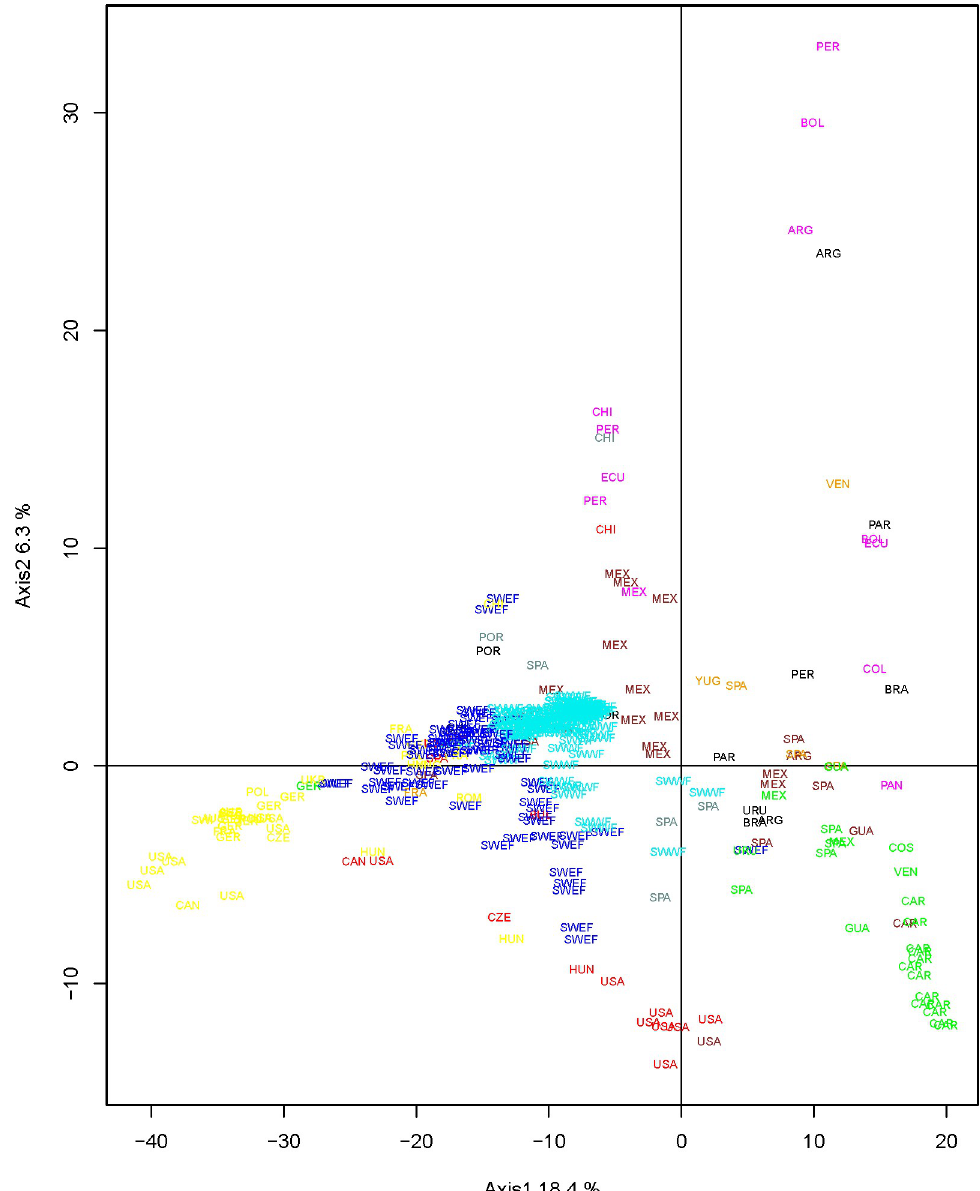
Fig 4. PCA analysis on SNP data of 72 American maize landraces with 260 maize landraces from Europe and those of CBD as supplementary data. Labels indicate landrace country of origins (see S2 Table). South-West France landraces were colored according to their admixture result at K = 2 allowing to distinguish East (in blue) and West South-West France (in cyan) genetic groups. The remaining American and European landraces were colored according to their genetic groups previously identified by Camus-Kulandaivelu et al. [10]: Corn Belt Dent in red, Caribbean in green, Northern Flint in yellow, Mexican in brown, Italian Flint in orange, Andean in magenta, Pyrenees_Galicia_2 in grey. The 9 landraces from South America and 2 landraces from Portugal studied by Mir et al (2017) were colored in black.